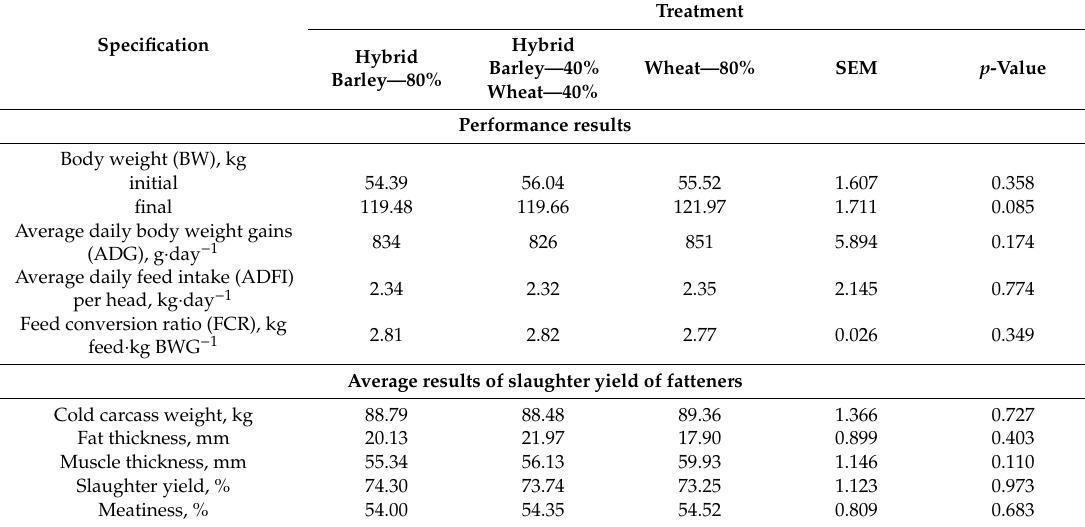
Table 4. Performance and slaughtering yield results of fattening pigs.